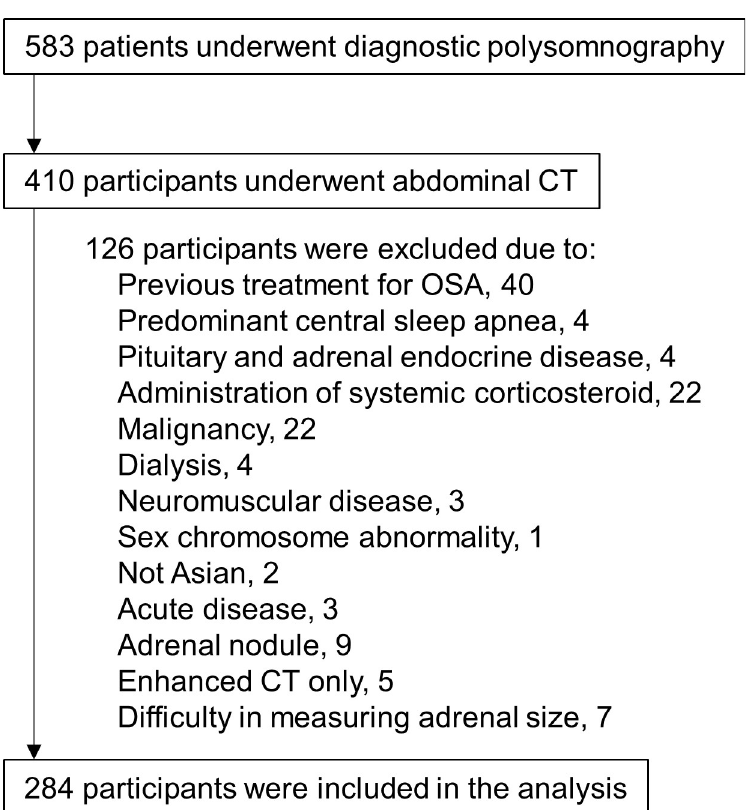
Fig 1. Flowchart of patient enrollment in the present study. CT: computed tomography, OSA: obstructive sleep apnea. body mass index: 25.6 [23.1–29.1] kg/m 2 vs. 24.7 [21.9–28.3] kg/m 2 , p = 0.014). The propor-